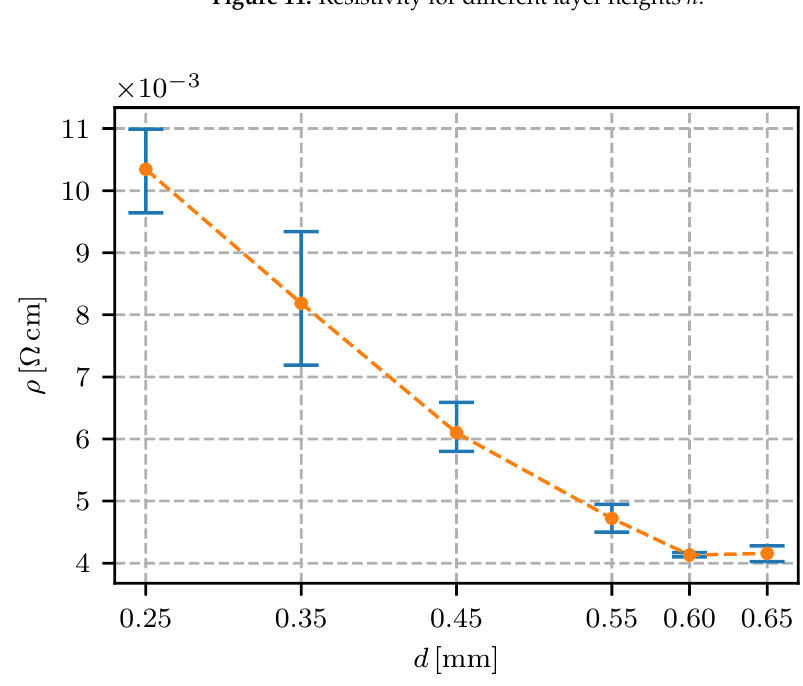
Figure 12. Resistivity for different trace spacings d